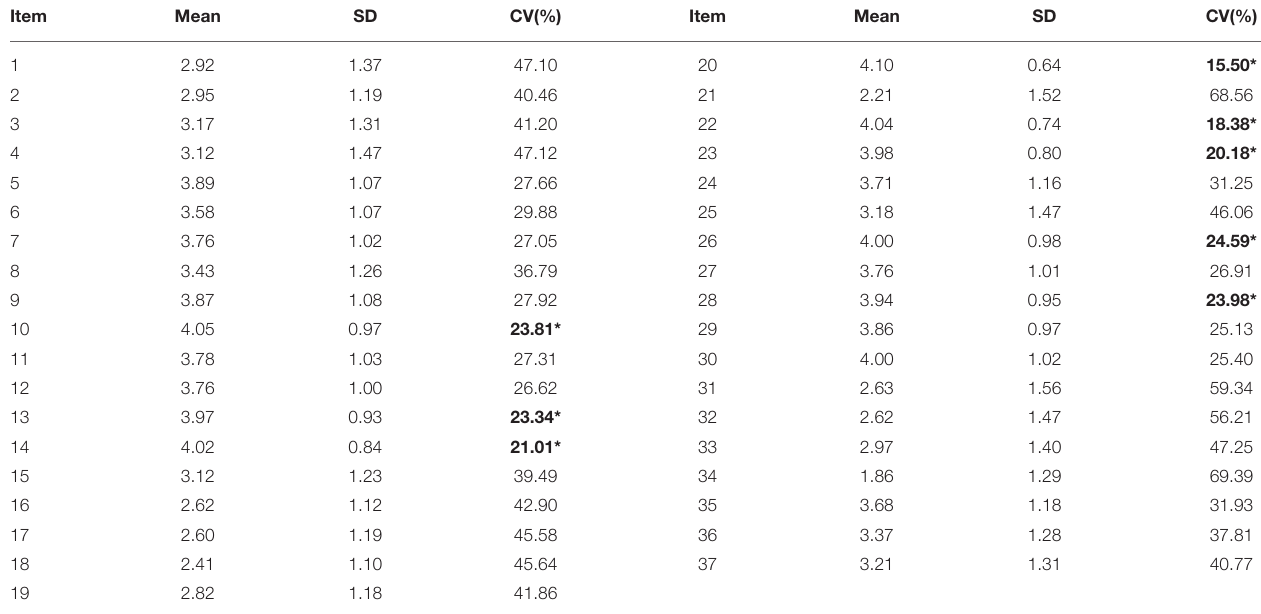
TABLE 2 | Mean, standard deviation, and coefficient of variation of each item ( N = 185).